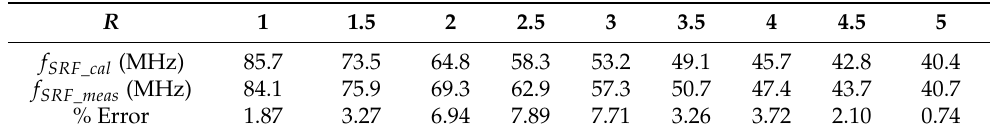
Table 13. Self-resonance frequency of elliptical planar inductors for varying major-to-minor ratios when trace separation ( S ) and trace width ( W ) were kept constant at 400 µ m.